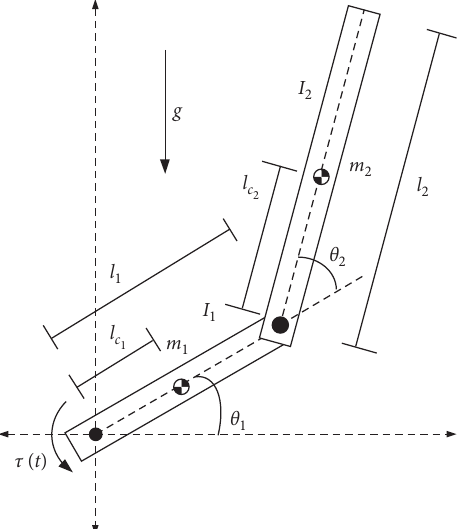
Figure 13: Schematics of the pendubot